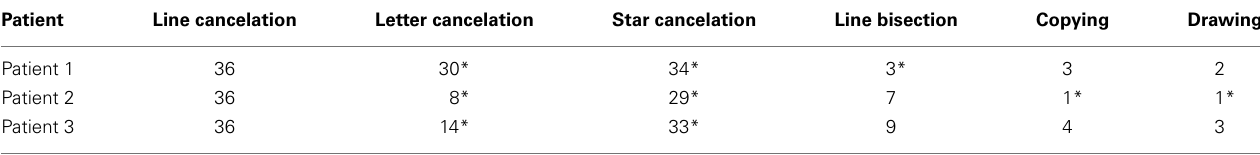
Table 2 |The profile of the conventional behavioral inattention test in all